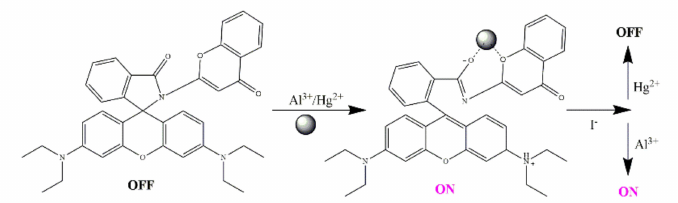
Figure 53. The sensing mechanism of the prepared sensor (Table 4, No. 4) for Al 3+ and Hg 2+ [109].